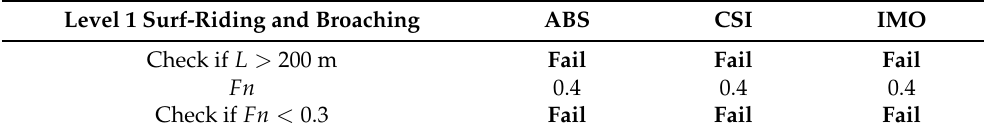
Table 39. Level 1 assessment of surf-riding/broaching failure mode for fishing vessel.